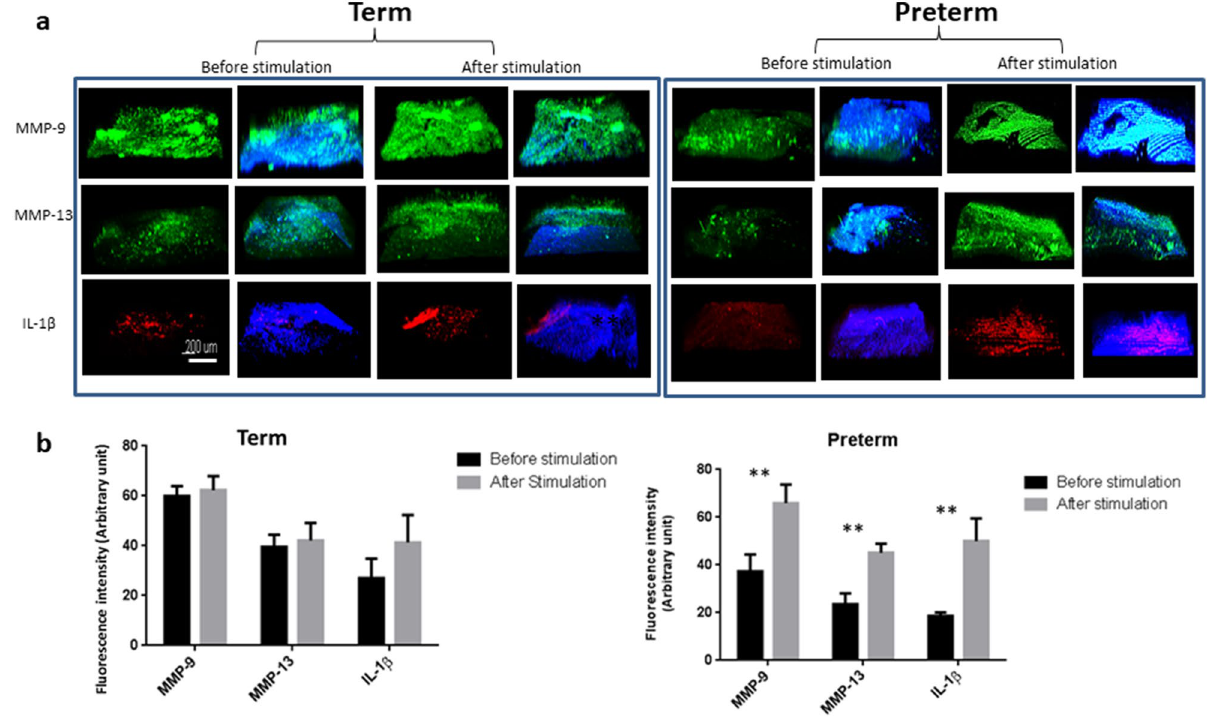
Figure 6. Immunohistochemical staining showing the effect of mechanical force on the change of key biomarkers expression with and without addition of nifedipine (nif). ( a ) Representative images showing biomarker expression, MMP-9 (green), MMP-13 (green) and IL-1β (red), with counter staining by DAPI (blue) merged, before and after the 3 h cyclic loading plus 4 h post-loading incubation without addition of nifedipine. ( b ) Quantitative analyses of the immunostaining intensity of images in ( a ). ( c ) Representative images showing biomarker expression, MMP-9 (green), MMP-13 (green) and IL-1β (red), with counter staining by DAPI (blue) merged, before and after the 3 h cyclic loading plus 4 h post-loading incubation with addition of 10, and 30 µM nifedipine for term membranes. The loaded samples without addition of nifedipine were used as control. ( d ) Quantitative analyses of the immunostaining intensity of the images in ( c ). ( e ) Representative images showing biomarker expression, MMP-9 (green), MMP-13 (green) and IL-1β (red), with counter staining by DAPI (blue) merged, before and after the 3 h cyclic loading plus 4 h post-loading incubation with addition of 10, and 30 µM nifedipine for preterm membranes. The loaded samples without addition of nifedipine was used as control for preterm samples. ( f ) Quantitative analyses of immunostaining intensity of the images in ( e ). Fn fibronectin, IL interleukin, MMP metalloproteinase. Scale bar is 200